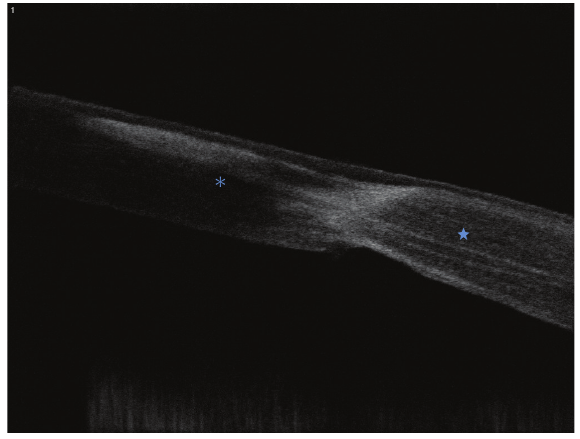
Figure 1: Horizontal section with RTVue OCT of a patient who underwent traditional PK three years ago. Note the malapposition between the donor (asterisk) and the host cornea (star). during the procedure 8 to 15%), faster recovery, absent of endothelial rejection, greater trauma resistance, and others [16, 17].